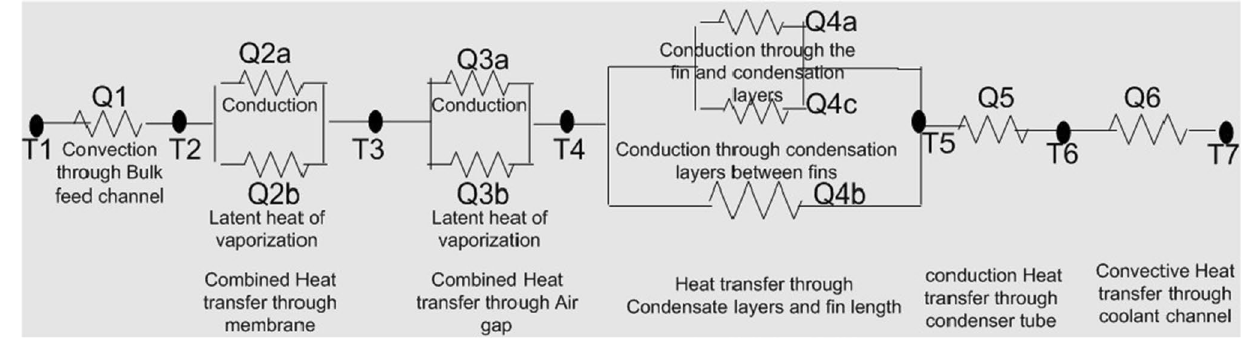
Fig. 3 Heat flow circuit in